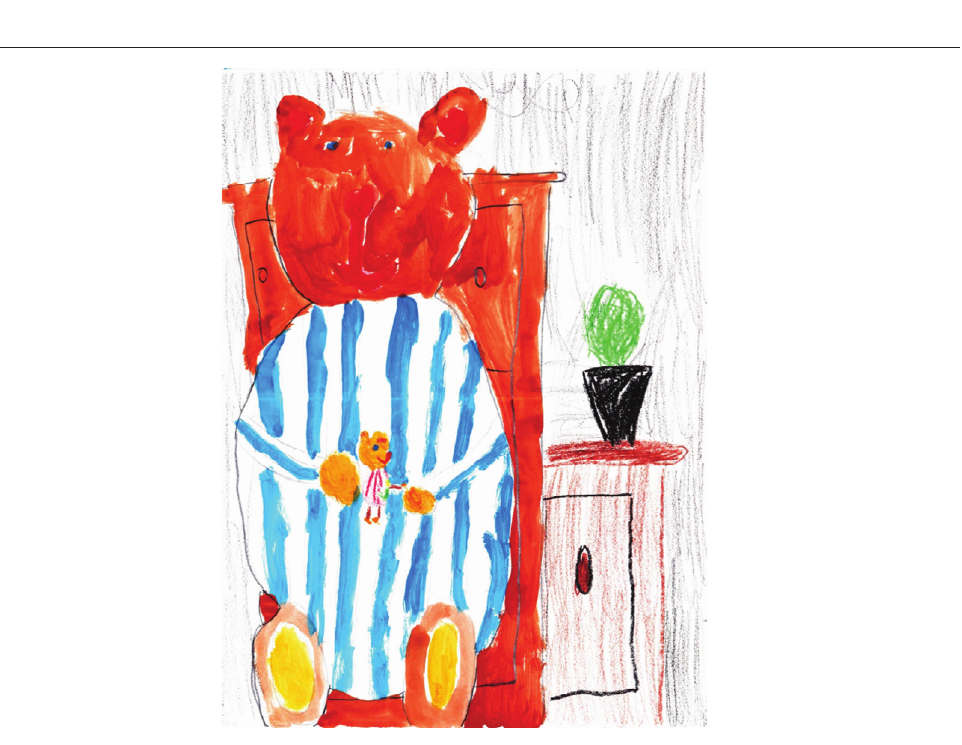
Figure 4: A primary school child expresses the friendship of Ernest and Célestine Teachers found that using visual language and aspects of role play helped children express their own feelings. For example, one primary teacher asked their first-grade students to each play Paddington in a situation where the character was sitting alone at the railway station. The students felt what it is like to depend on others who are passing by, and talked about these feelings in